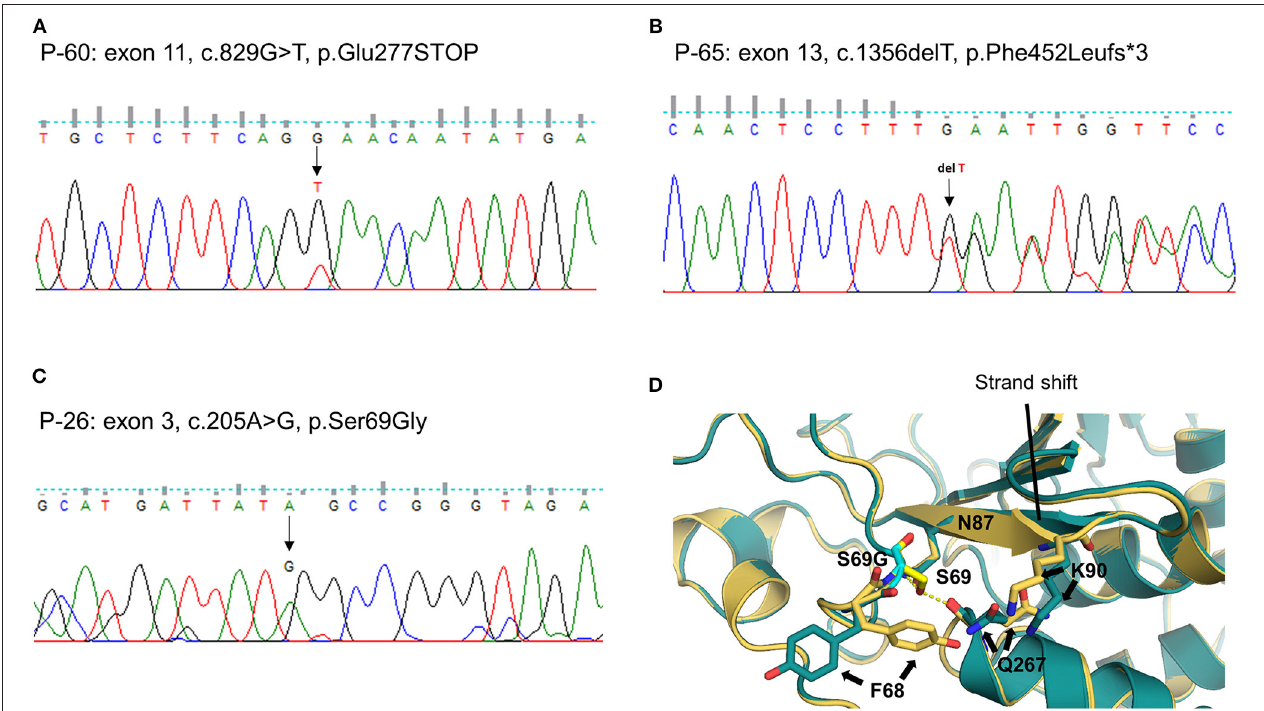
FIGURE 2 | Sequencing results and protein structural modeling of the rare variants in PTPN22 identified by targeted next-generation sequencing. The chromatograms show three rare heterozygous variants: (A) one is a nonsense variant in exon 11 resulting in a premature stop codon (c.829G > T, p.E277X, P-60); (B) another is single base deletion in exon 13 that leads to frameshift and premature stop codon 3 amino acids downstream (c.1356delT, p.F452Lfs*3, P-65); (C) the other is a missense rare variant in exon 3 causing the substitution of highly conserved serine by glycine at position 69 (c.205A > G, p.S69G, P-26). Protein structural modeling predicts that p.S69G variant may affect the enzyme activity of PTPN22 by a disruption of hydrogen bonds network between p.S69 and p.N87 residues, and the steric hindrance effect resulting from the rotation of p.F68, p.Q267, and p.K90 residues (D) , yellow: wild type PTPN22, teal: p.S69G mutant